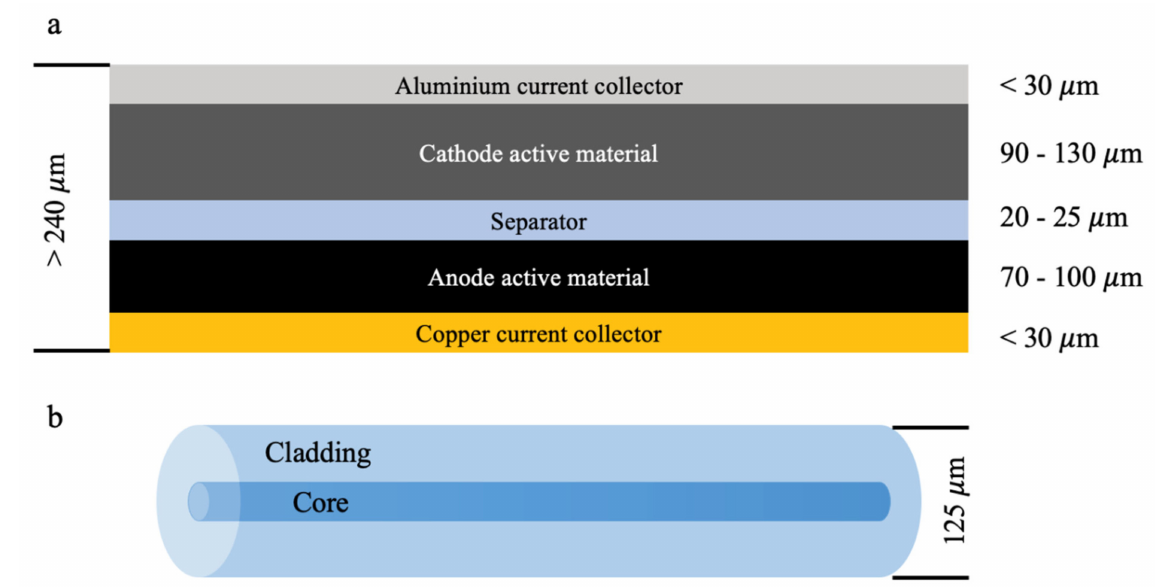
Figure 2. Schematic of LiB component thickness. LiB cell component thickness comparison ( a ) to a typical optical fibre used for temperature detection ( b